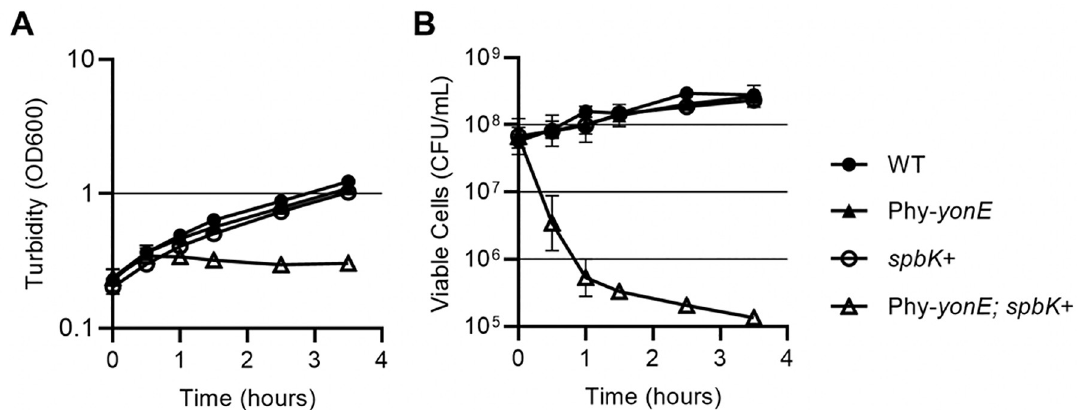
Fig 5. Co-expression of spbK and yonE kills cells and results in a growth defect. Strains null for ICE Bs1 and SPß (closed circles, PY79), expressing yonE (closed triangles, amyE ::{Pspank(hy)- yonE }, CMJ616), expressing spbK (open circles, lacA :: spbK , CMJ684), or both yonE and spbK (open triangles, CMJ685) were grown in minimal medium. yonE expression was induced by the addition of 1 mM IPTG and the culture turbidity ( A ), and cell viability ( B ) were followed over time. T = 0 samples were collected immediately prior to induction with IPTG. Cell viability was measured as the number of colony forming units per ml, measured by plating for CFUs on LB plates made with Noble agar. Experiment was repeated 3 times.